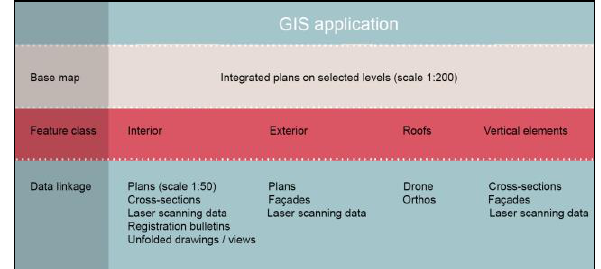
Figure 13 . Workflow of the GIS application.